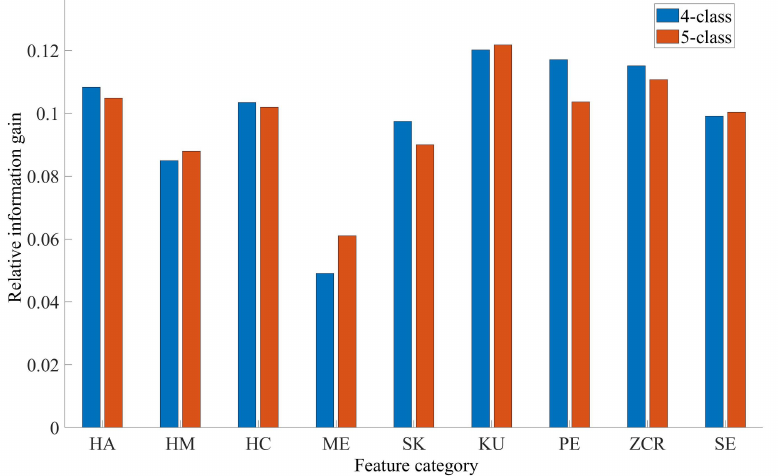
Figure 7. Relative information gain of DREAMS Subjects database features in the XGBOOST